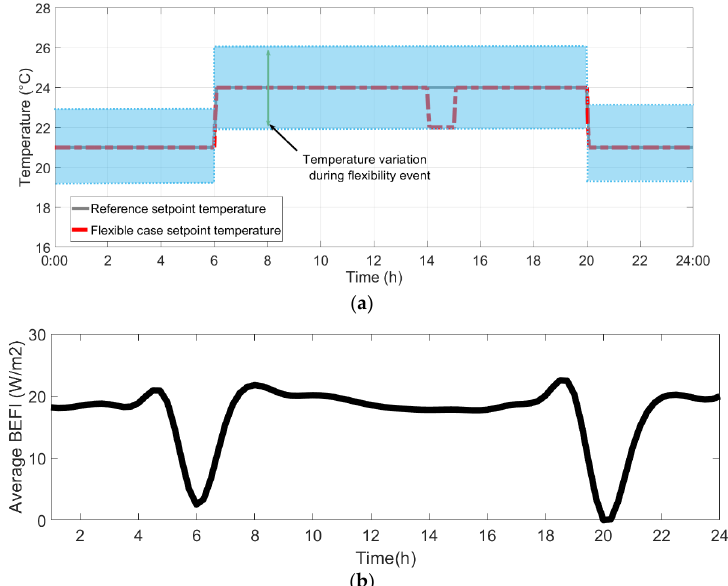
Figure 9. ( a ) Daily setpoint profile with acceptable temperature band and a flexibility event with a duration of 1 h at 2 pm; ( b ) energy flexibility curve, 1 h event.